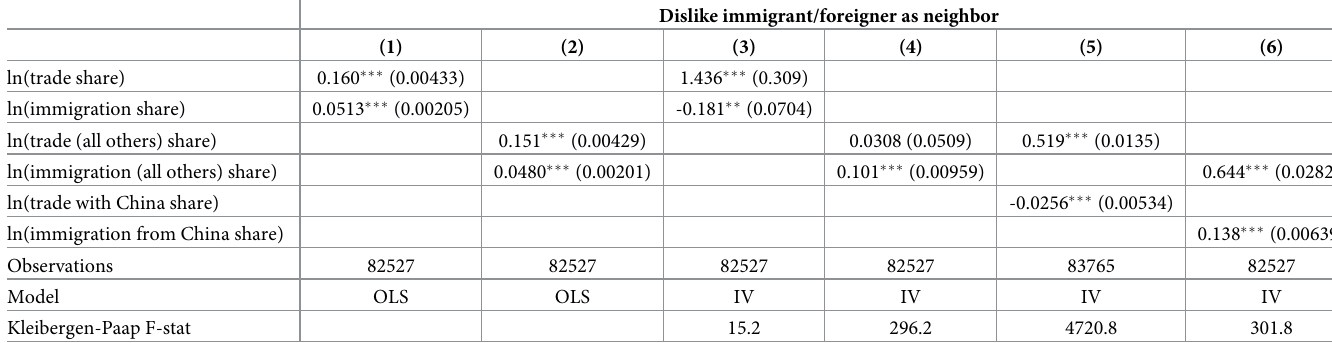
Table 8. Discrimination, openness to trade and immigration